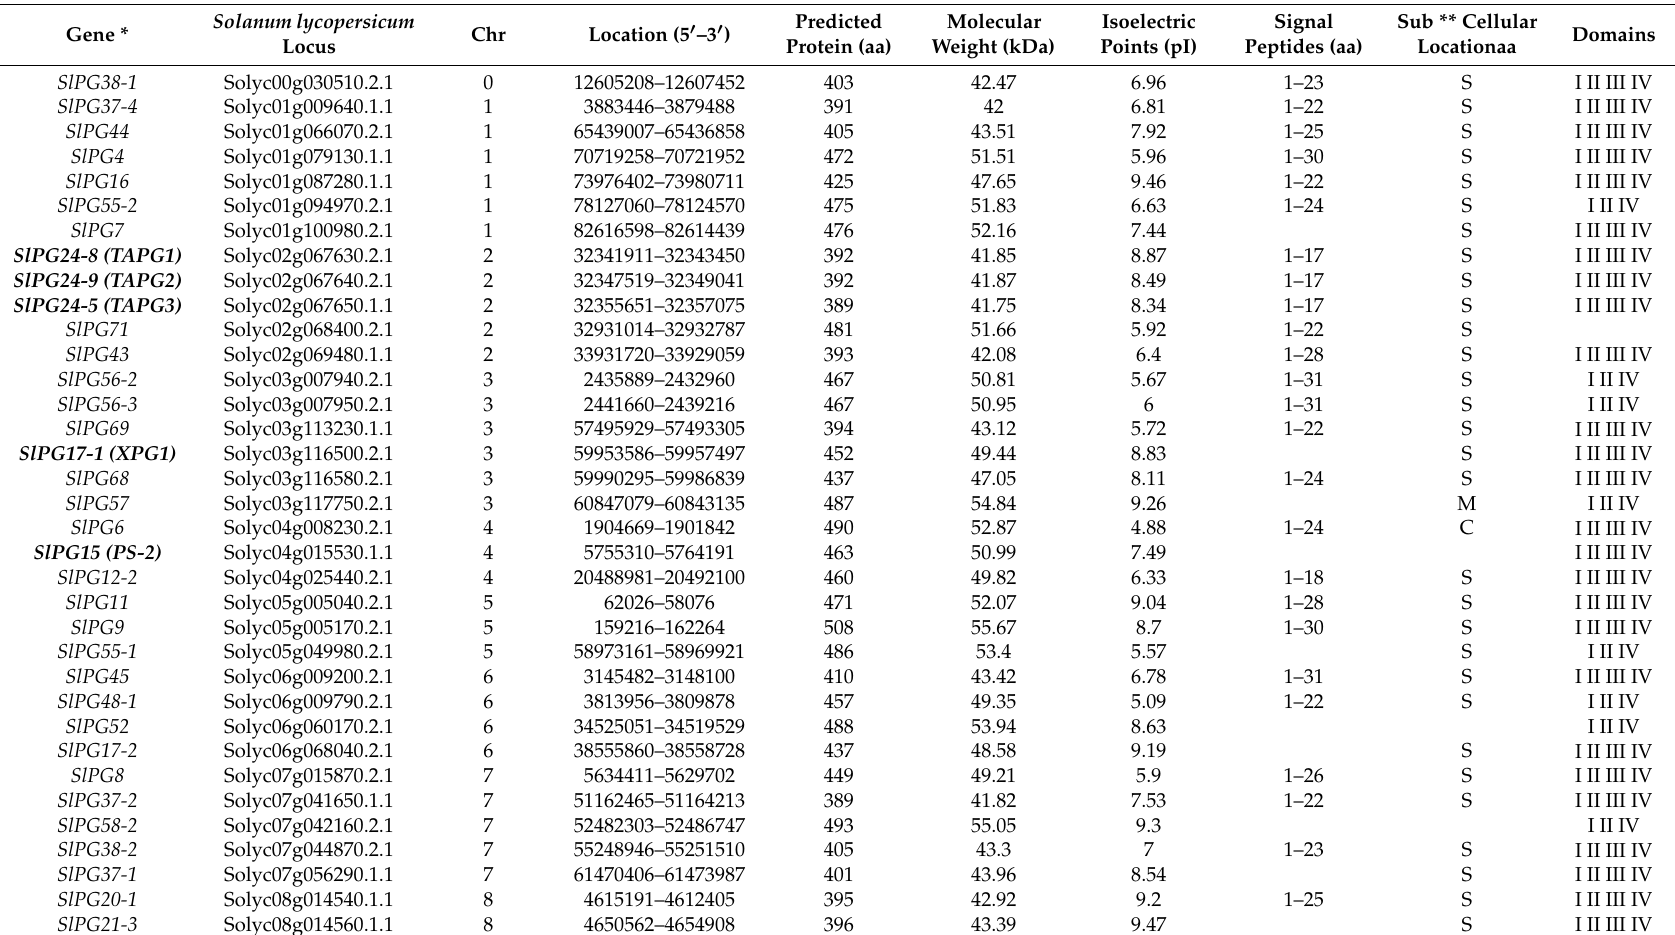
Table 1. The polygalacturonase (PG) gene family in Solanum